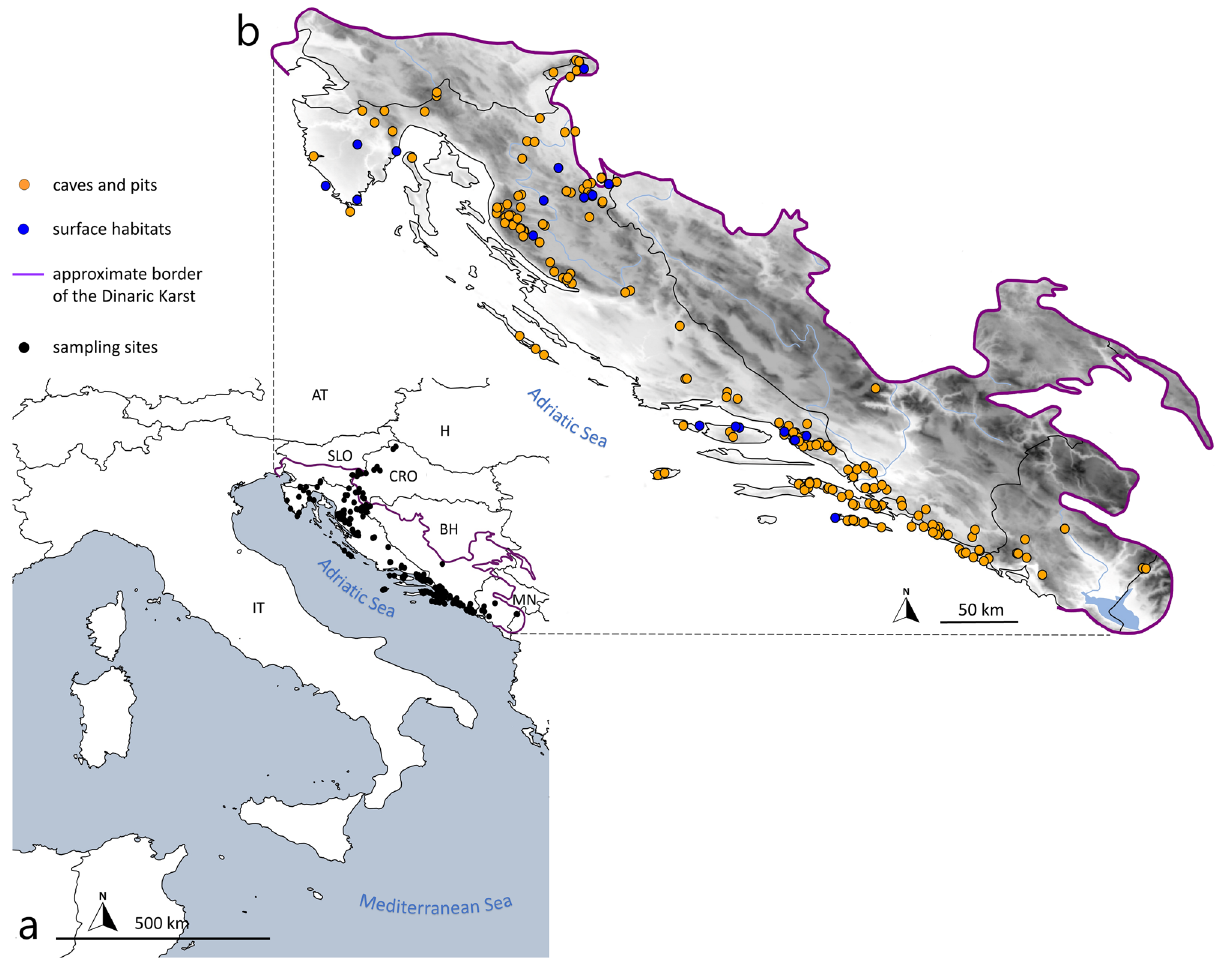
Figure 2. Distribution of georeferenced DNA barcode records is represented with black dots on the map (a). The main map ( b ) is an enlarged Dinaric Karst area marked in the bottom left corner ( a ). For locality references see Supplementary Table 1 online. Approximate border of the Dinaric Karst according to 35 . Map is produced with Cartopy package ver. 0.19 (https:// scito ols. org. uk/ carto py/ docs/ v0. 18/ index. html) in Python ver. 3.8 with use of elevation data from 36 . Abbreviations: IT Italy, AT Austria, SLO Slovenia, CRO Croatia, H Hungary, BH Bosnia and Herzegovina, MN